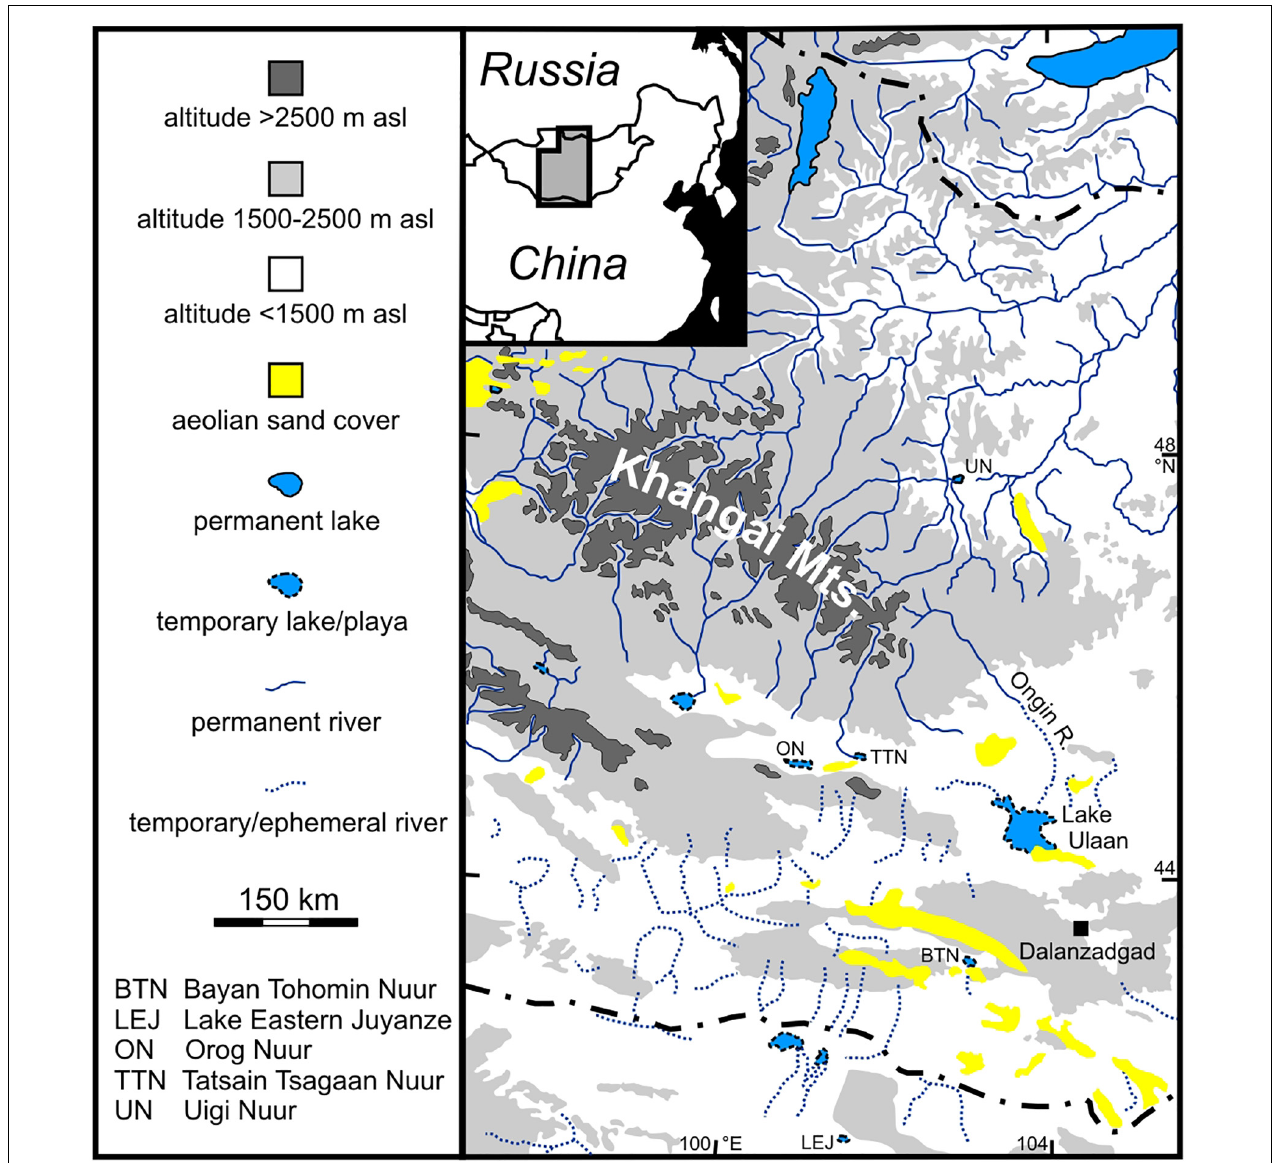
FIGURE 1 | Location of Lake Ulaan and its main tributary, the Ongin River, in Mongolia. Based on Lehmkuhl et al. (2018),